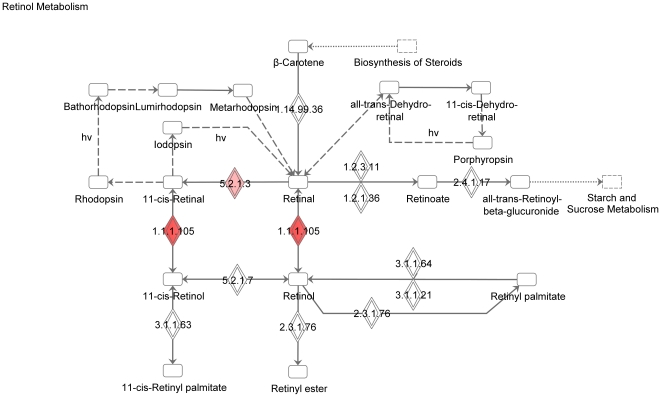
The retinol metabolism pathway identified by the Ingenuity software.This is one of the canonical pathways that contains statistically significantly more genes than expected by chance in the group of 114 genes with RPE-specific expression. This figure shows the proteins corresponding to the overrepresented genes. Colored symbols indicate their presence among the 114 genes with RPE-specific expression, uncolored genes are added by the software to form pathways. Solid lines between molecules indicate direct physical relationships between molecules (such as regulating and interacting protein domains); dotted lines indicate indirect functional relationships (such as co-regulation of expression of both genes in cell lines).